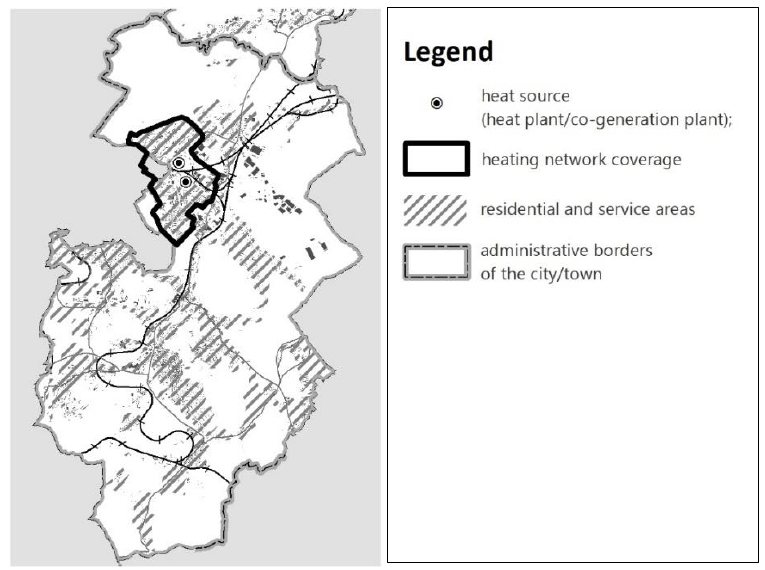
Figure 2. Areas intended for housing and service development, and the range of the district heating network in Wałbrzych. * HSAs—housing and service areas.